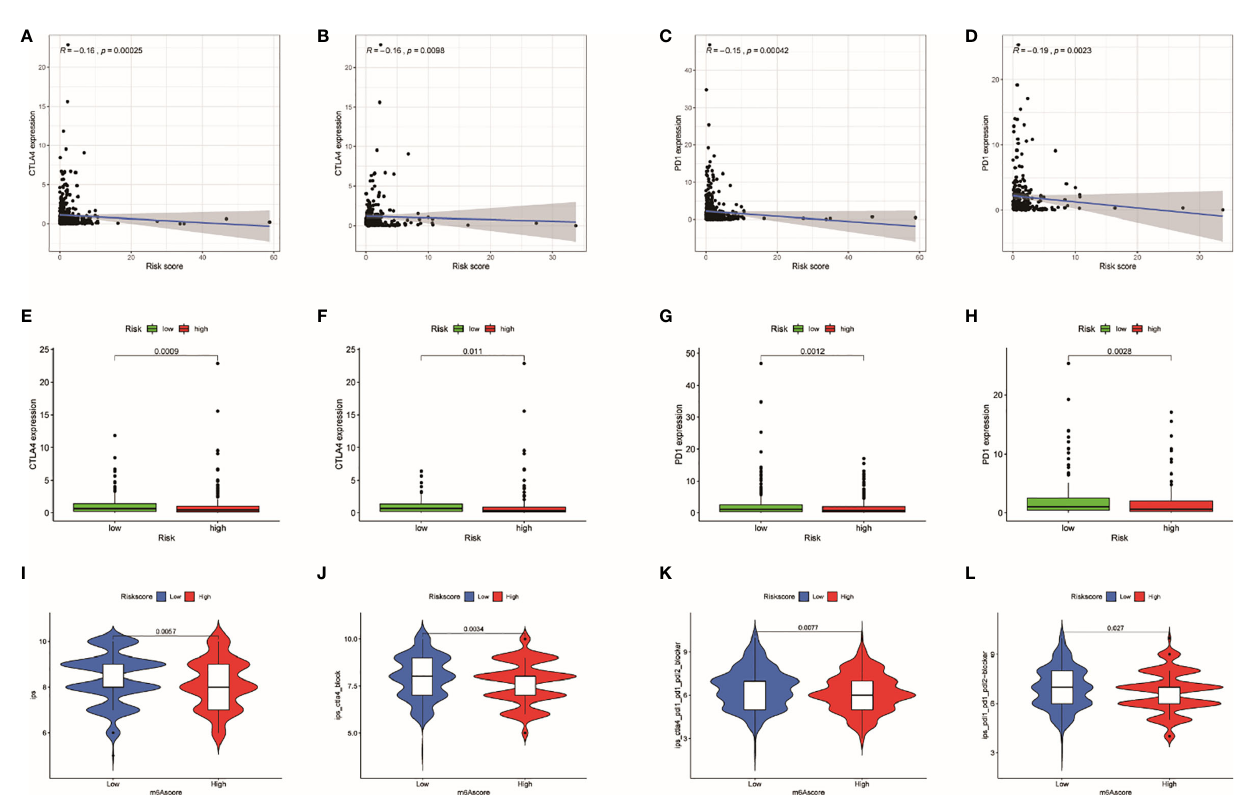
FIGURE 9 | The relationship of risk score with immune checkpoints. (A) Relationship between risk score with CTLA-4 expression in the entire set. (B) Relationship between risk score with CTLA-4 expression in the train set. (C) Relationship between risk score with PD1 expression in the entire set. (D) Relationship between risk score with PD1 expression in the train set. (E) Differences in CTLA-4 expression between high- and low-risk patients in the entire set. (F) Differences in CTLA-4 expression between high- and low-risk patients in the train set. (G) Differences in PD1 expression between high- and low-risk patients in the entire set. (H) Differences in PD1 expression between high- and low-risk patients in the train set. (I – L) The association between IPS and the TRRS in UCEC